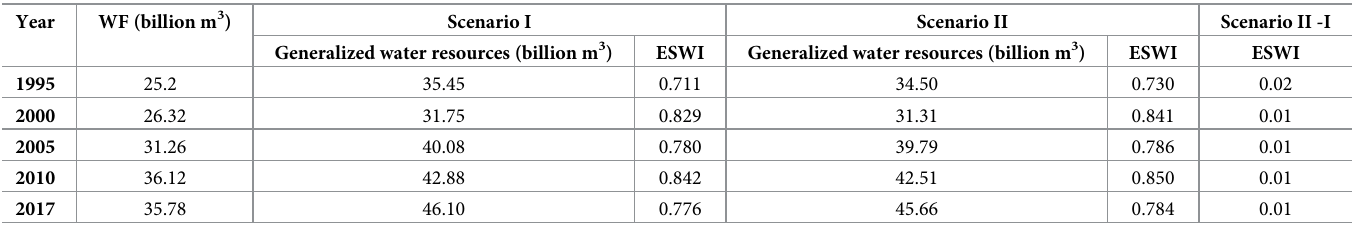
Table 7. Ecological water stress index values of the two land use scenarios in the Yanhe River